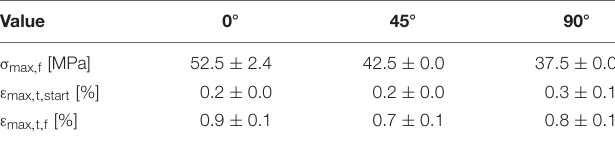
TABLE 2 | Direction-dependent fatigue properties of